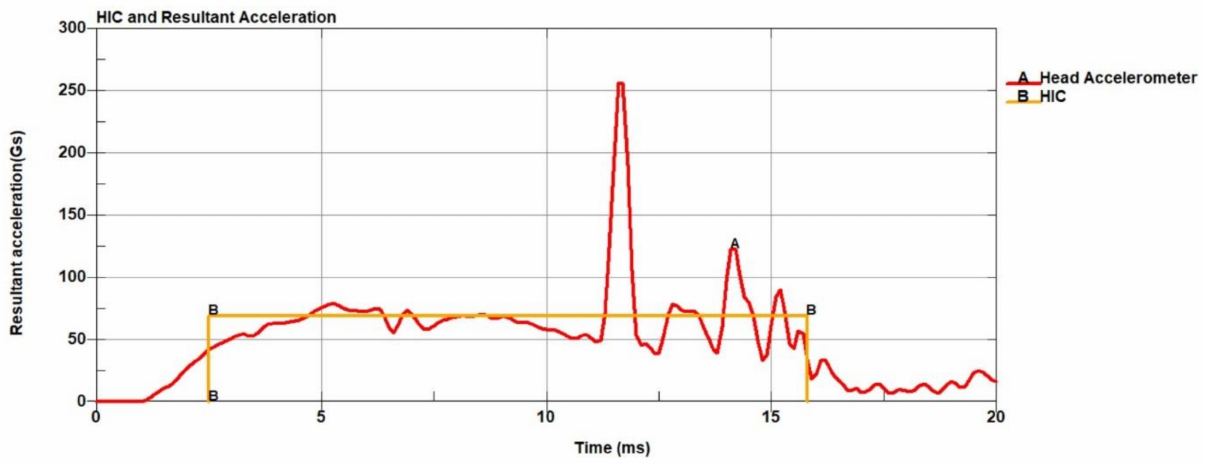
Figure 8. HIC and resultant acceleration (g) in time (ms) plot (HIC =